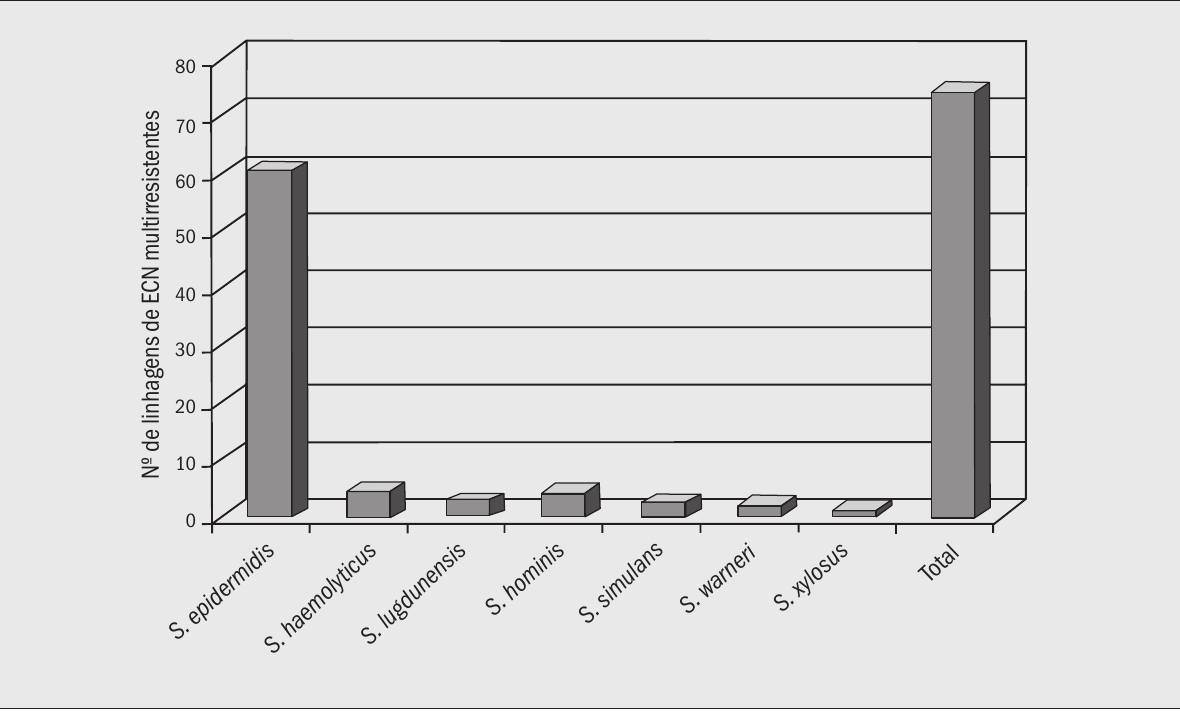
Figura 7 – Freqüência de linhagens de ECN multirresistentes segundo as